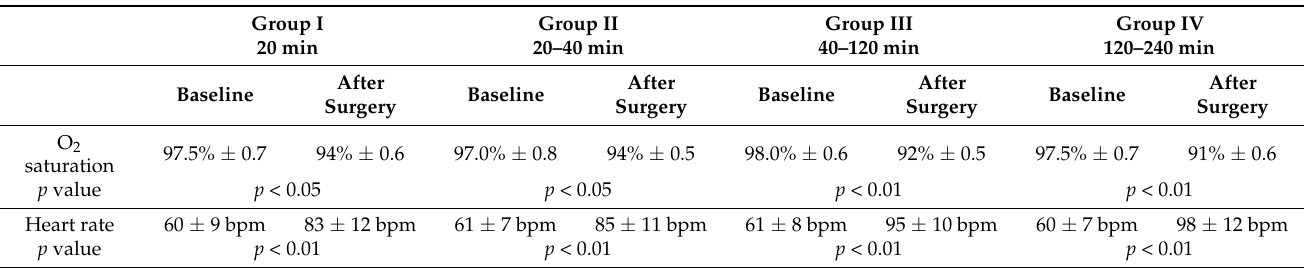
breath scored 30.33 ± 7.17 while light-headedness and headaches scored 21.33 ± 5.85.